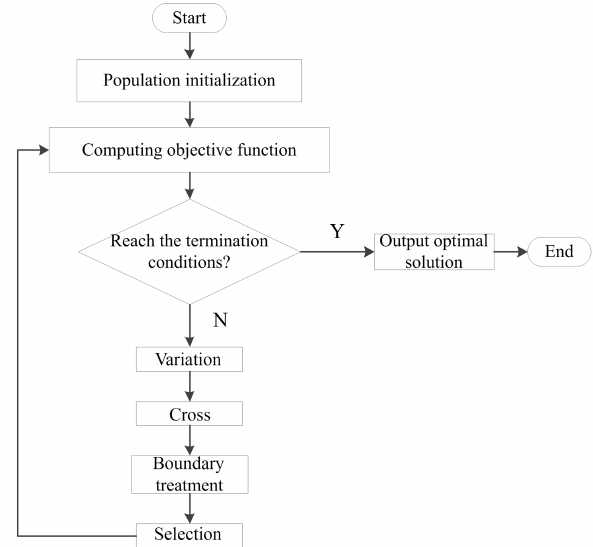
Figure 3. The procedure of the SADE algorithm. (cid:13) (cid:13)